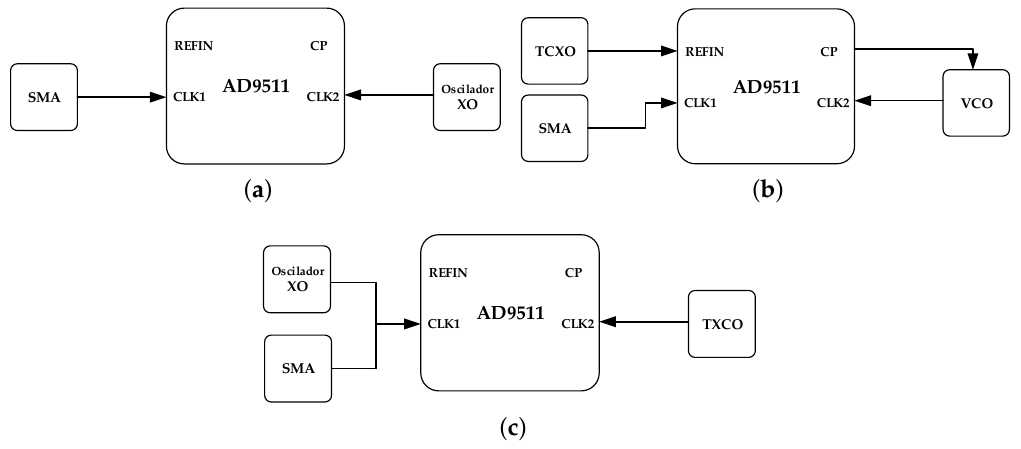
Figure 2. Clock input diagram of the clock distributor: ( a ) Crystal Oscillator scheme; ( b ) VCO using an accurate Temperature Compensated Crystall Oscillator (TCXO); ( c )